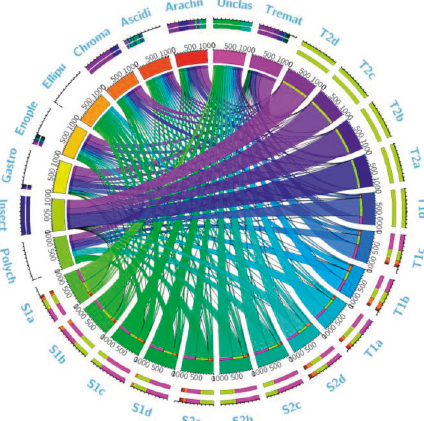
Figure 2: Soil invertebrate at class level (relative abundance). T1a–d and T2a–d mean termite mounds from Braklaagte and Zeerust, respectively, while S1a–d and S2a–d mean adjacent soils from Braklaagte and Zeerust, respectively. The labels Gastropoda, Arachnida, Enoplea, Polychaeta, Ascidiacea, Trematoda, Insecta, Ellipura, and Chromadorea were shortened to Gastro, Arachn, Enople, Polych, Ascidi, Tremat, Insect, Ellipu, and